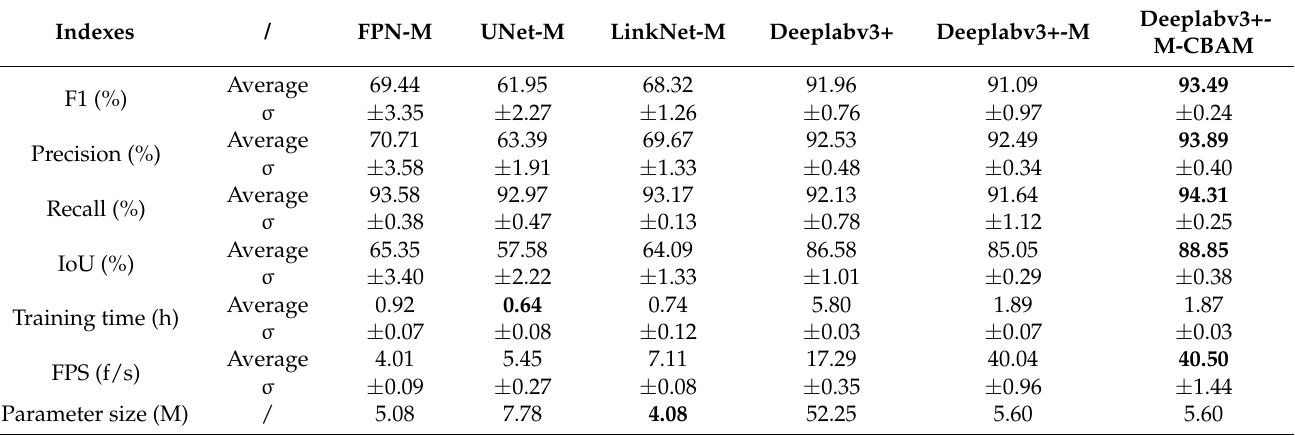
Table 4. The performance comparison for training the different models on BSL validation set.